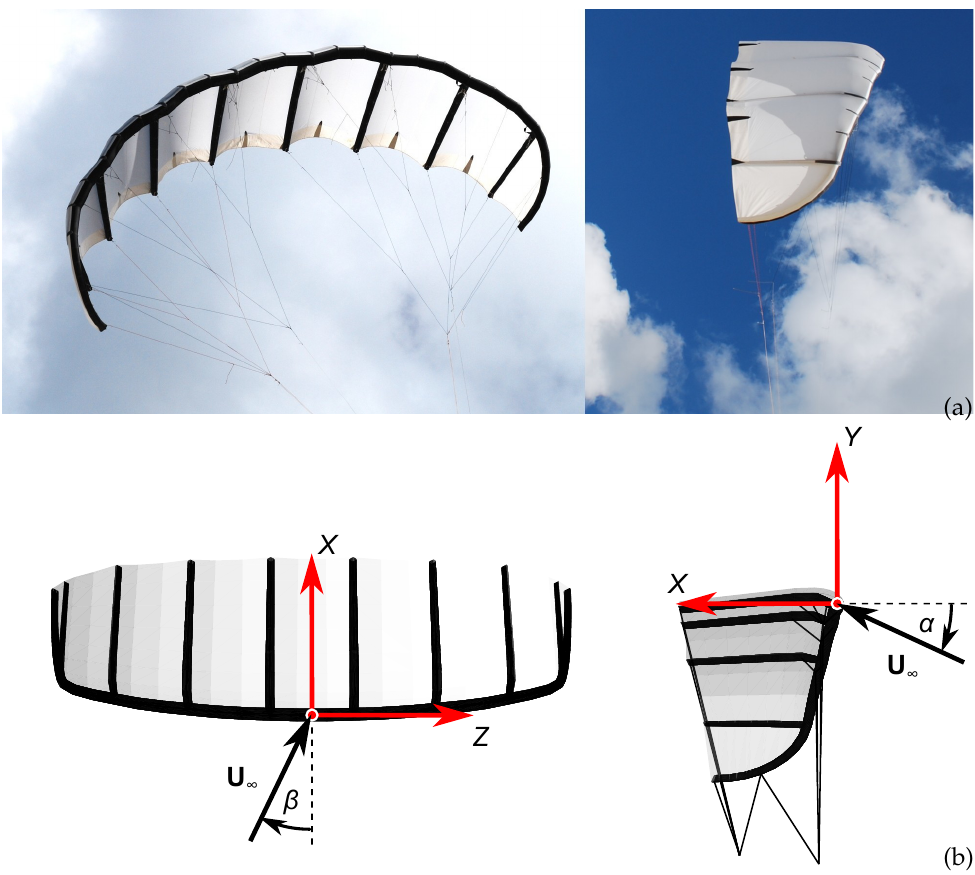
Figure 1. TU Delft V3A kite with 25 m 2 wing surface area: ( a ) during flight and ( b ) design geometry with body-fixed reference frame ( X , Y , Z ) and definition of the side-slip angle β and angle of attack α to describe the direction of the undisturbed inflow velocity U ∞ relative to the